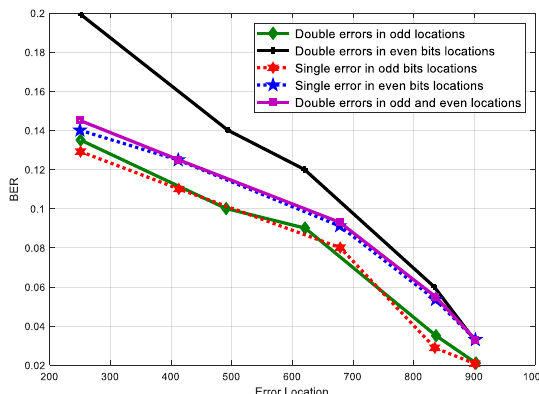
Figure 11 Comparison of the effects of single and double errors on even and odd locations.